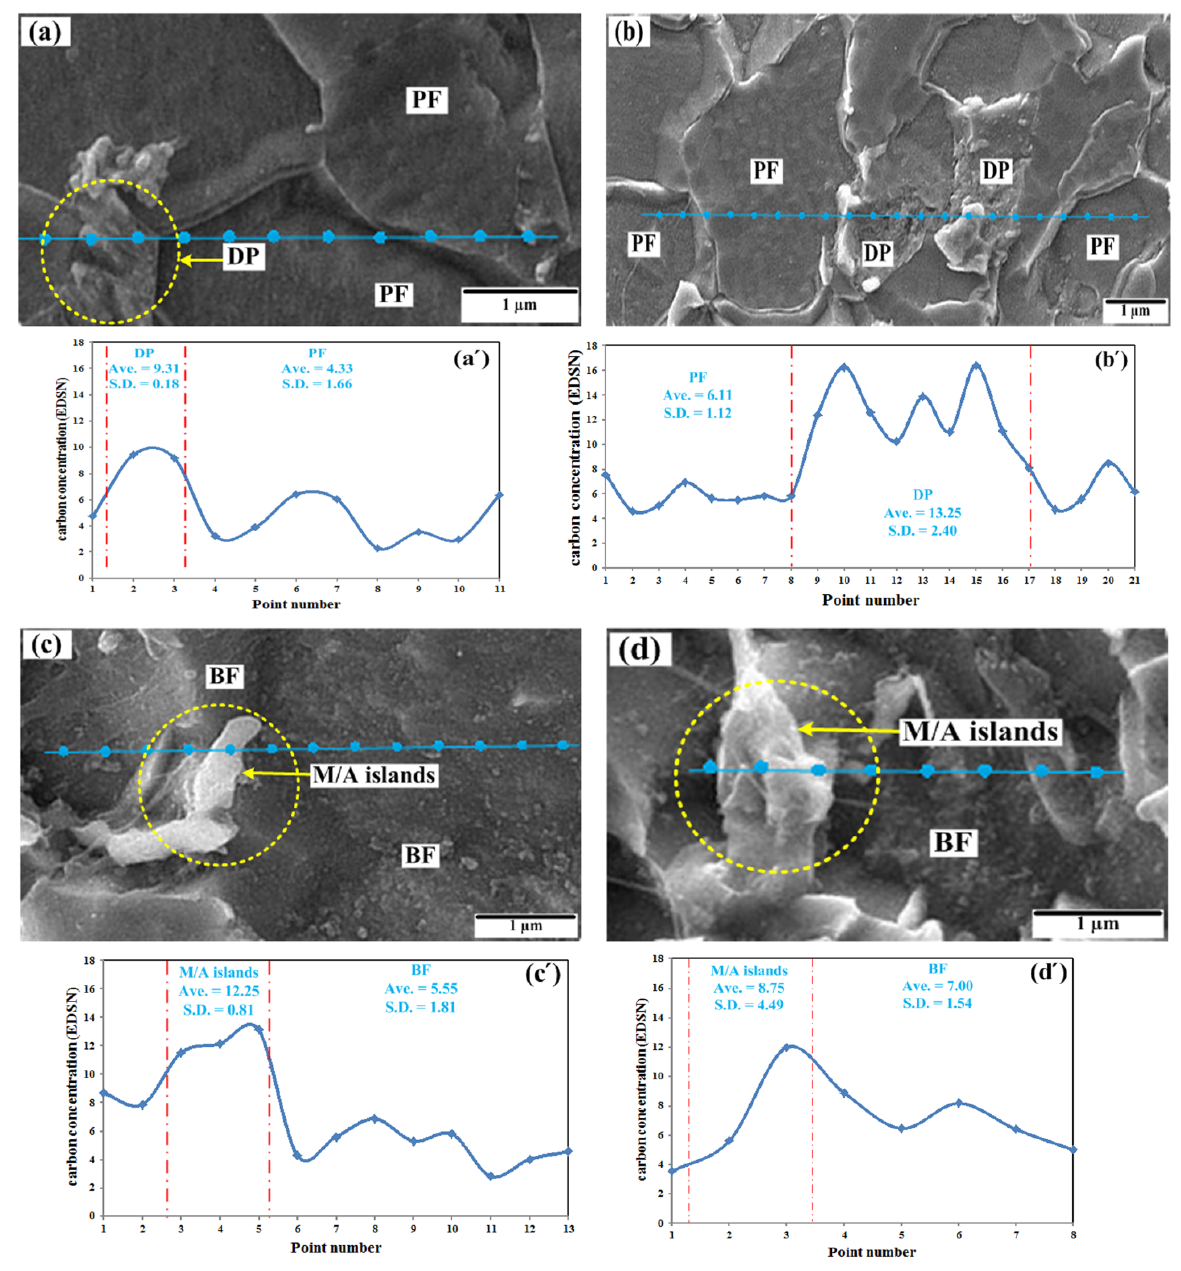
Figure 5: FE-SEM secondary electron micrographs with superimposed EDS spot-line scanning for the carbon analysis, showing the variation in the carbon concentration in terms of the EDS number (EDSNs) within the microconstituent observed in a and a ′ ) CC0.3 sample; b and b ′ ) CC10 sample; c and c ′ ) CC50 sample; and d and d ′ ) CC360 sample. The average (Ave.) of the EDS numbers for the carbon concentration with the corresponding standard deviation (S.D.) of the data points is indicated. DP: Degenerate Pearlite; PF: Polygonal Ferrite; BF: Plate-Like Bainitic Ferrite; and M/A islands: martensite/austenite